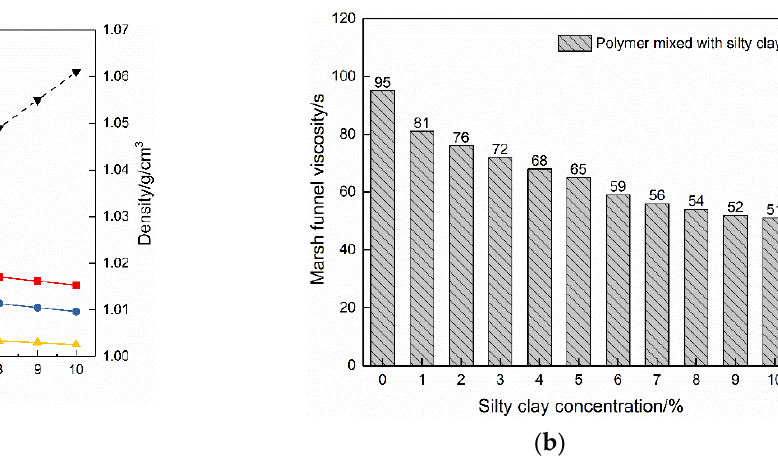
Figure 5. Effect of adding silty clay on polymer fluids: ( a ) changes in apparent viscosity and density; ( b ) changes in Marsh funnel viscosity.